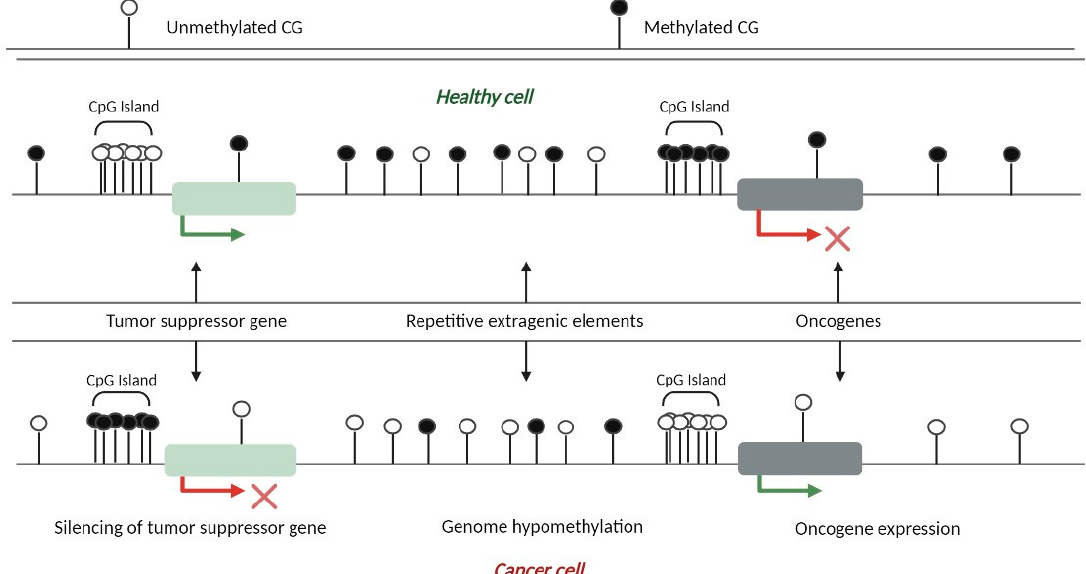
Figure 4. DNA methylation in normal and cancer cells. CpG dinucleotides present at a low density within the genomic sequence are mostly methylated (e.g., the silencing of transposable elements and the condensation of centromeric and subtelomeric regions). On the other hand, a small proportion of CpG dinucleotides in clusters named CpG islands are often found within the gene promoter regions. These CpG islands are rarely methylated in healthy cells. Aberrations in the epigenetic information in cancer cells are characterized by global genomic hypomethylation accompanied by aberrant hypermethylation of the CpG islands present in the promoter regions of tumor suppressor genes. The red arrow with the cross indicates the repression of transcription; the green arrow indicates active transcription. The green rectangle represents a promoter site for tumor suppressors and the gray rectangle shows a promoter site for oncogenes.